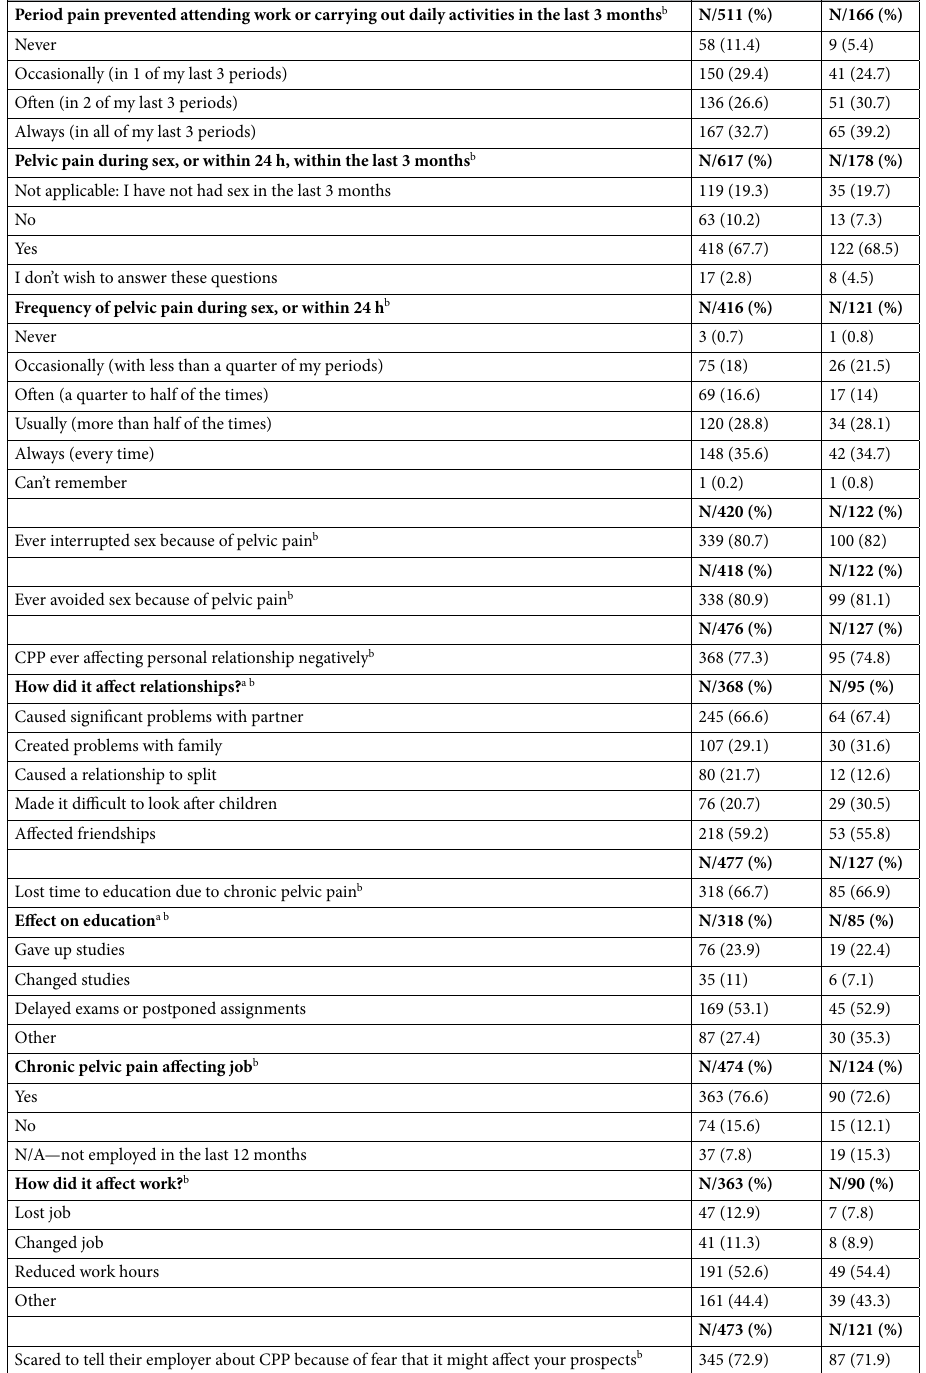
Table 3. Impact of pelvic pain symptoms on daily life. a Respondents were able to select more than one option. b Respondents were not required to answer all question fields in the